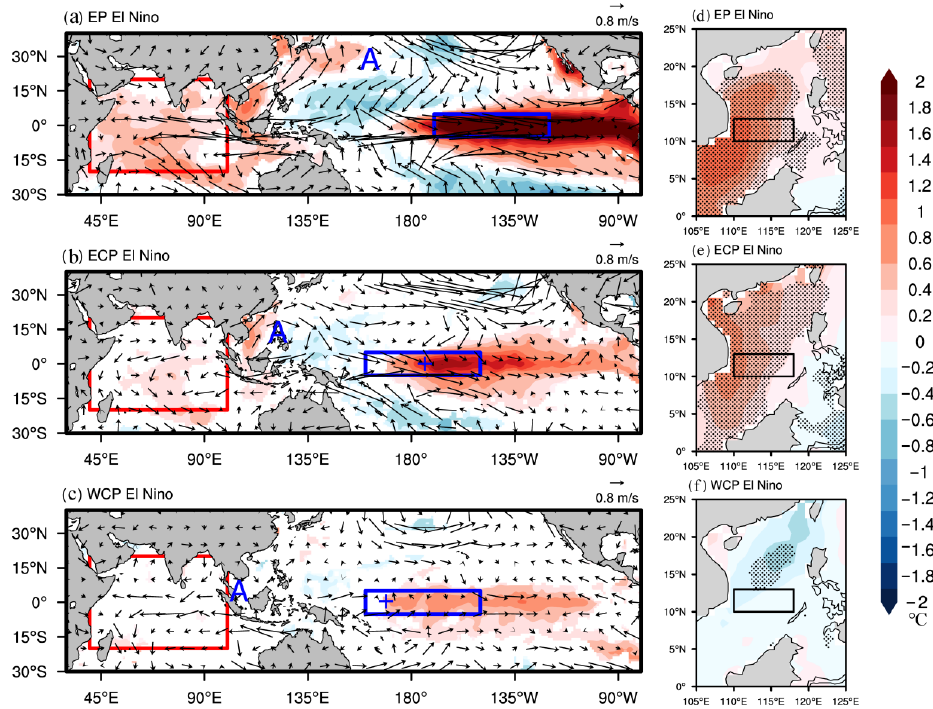
Figure 4. Composite SST anomalies (shaded, ◦ C) over tropical India–Pacific ( a – c ) and SCS regions ( d – f ) during boreal winter (DJF) for ( a , d ) EP El Niño, ( b , e ) ECP El Niño and ( c , f ) WCP El Niño. Only values reaching 85% significance level are shown in ( a – c ), the stippled area in ( d – f ) repre- sents the values exceeding the 85% significance level. Vectors in ( a – c ) show anomalous wind (m · s − 1 ) at 850 hPa. The blue rectangle denotes the Niño3.4 region in ( a ) and the Niño4 region in ( b , c ), with “+” symbols standing for the location of the maximum zonal gradient of the equatorial (5 ◦ S–5 ◦ N) mean SSTA. Symbols A in ( a – c ) represent anomalous anticyclone and cyclone. Red rectangles in ( a – c ) represent the tropical Indian Ocean. Black rectangles in ( d – f ) represent the CT